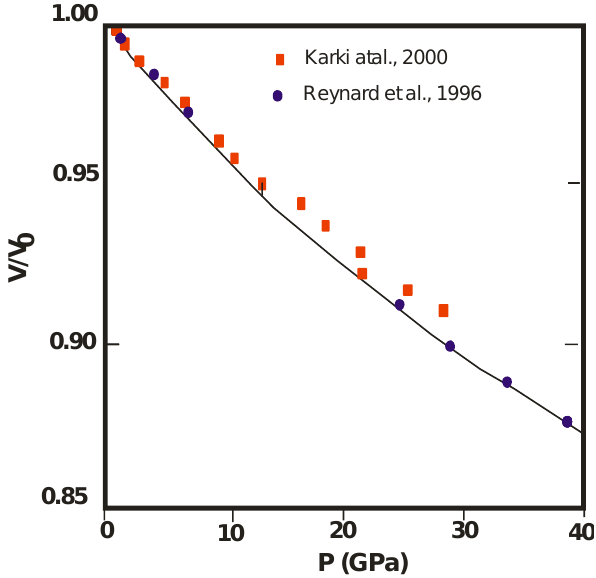
Figure 6. Correlations between the compression of unit cell vol- umes V/Vo in ilmenite structure vs pressure (Karki et al., 2000; Reynard et al.,